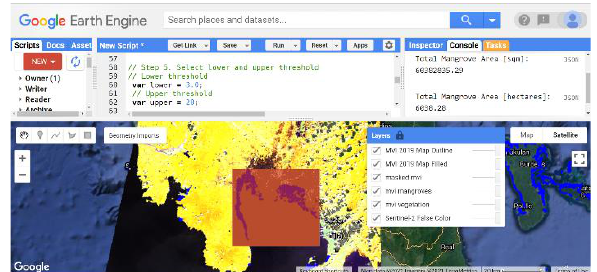
Figure 3. Products generated after running the GEE script to assess the MVI-based 2019 Mangrove Extent Map of the Philippines.